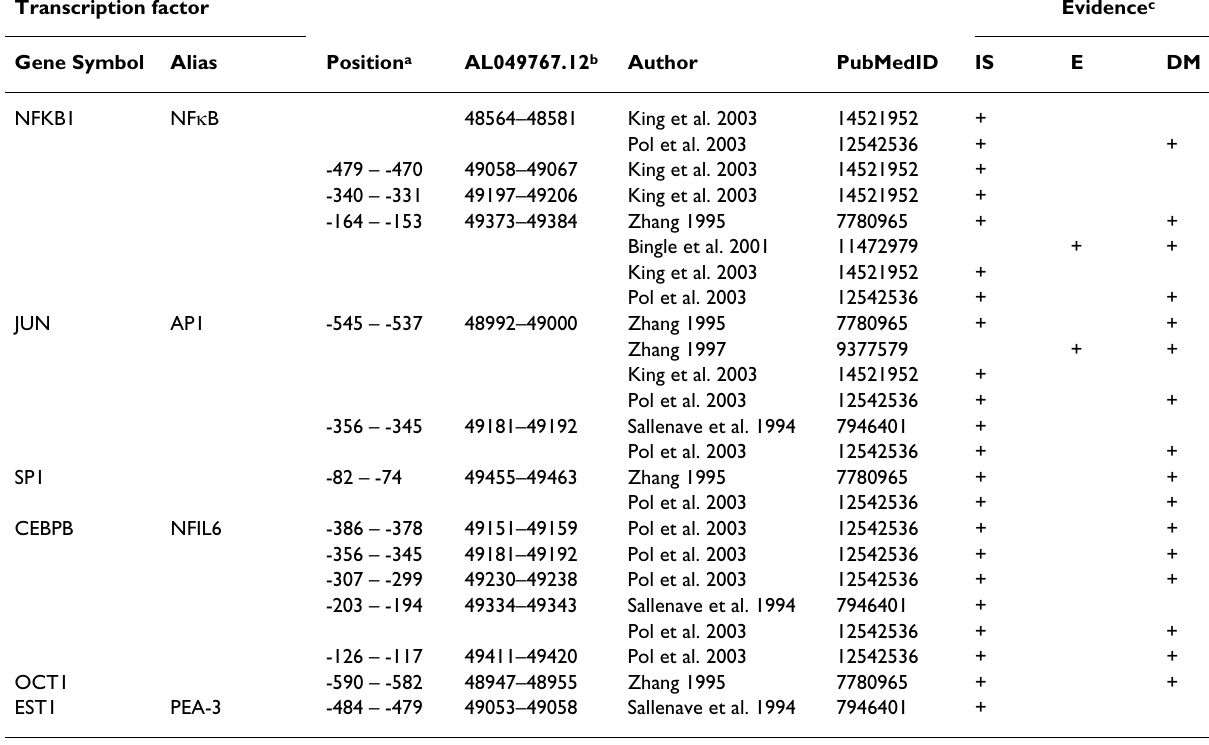
Table 5: Previously reported transcription factor binding sites in the PI3